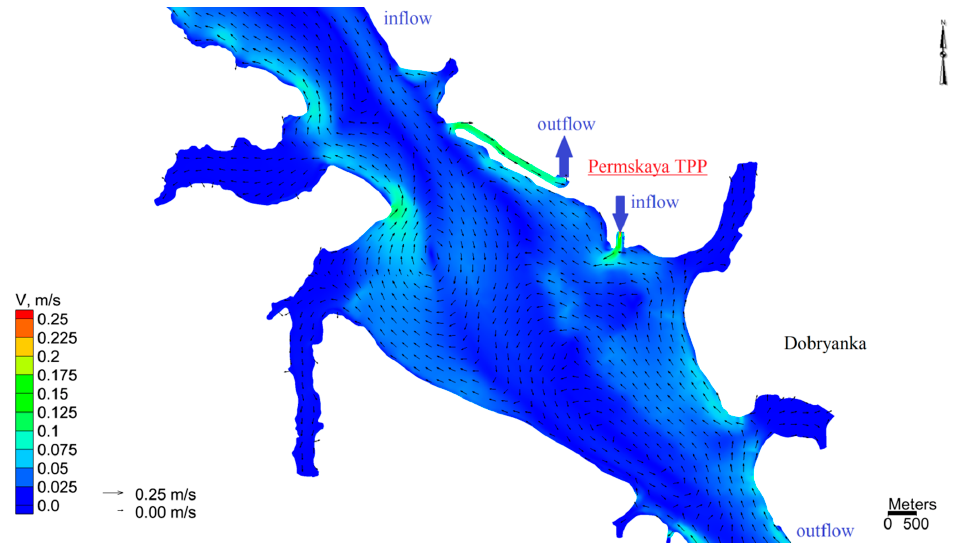
Figure 6. The velocity vector field in the vicinity of Dobryanka town at 4 days, 1 h from the start of calculations, which corresponds to 1 h at night (back flows, calm conditions).